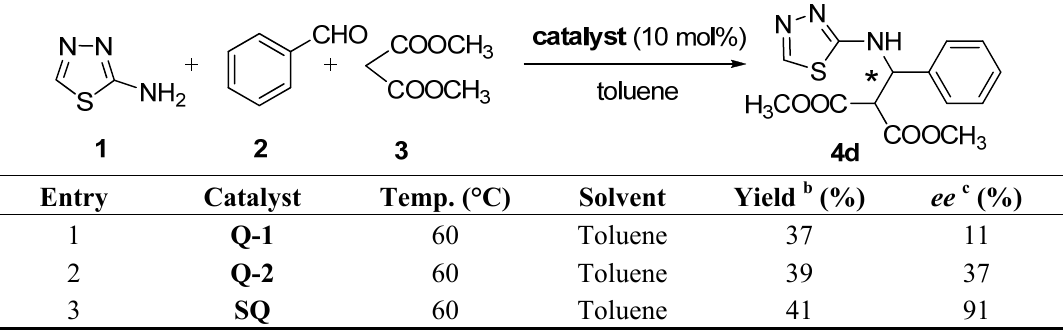
Table 1. Screening of various catalysts a .